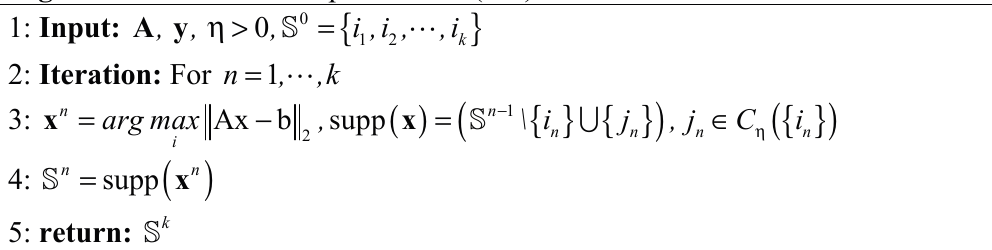
Algorithm 2 Coherence Optimization (CO)